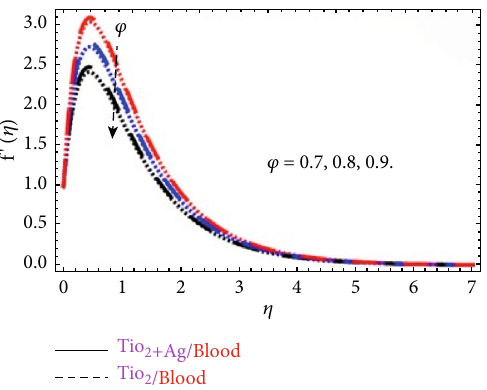
Figure 1: Inspiration of Casson parameter β on velocity pro fi le.